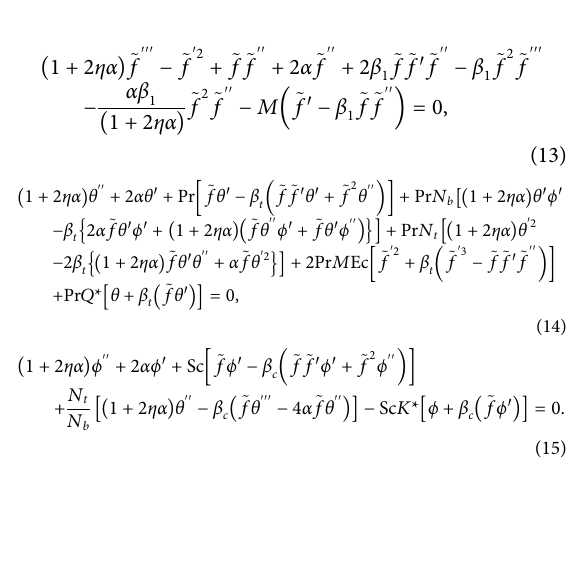
The dimensionless parameters involve the fl uid relaxation time parameter β 1 , the curvature parameter α , the magnetic fi eld parameter M , the Prandtl number Pr, the Schmidt number Sc, the Brownian diffusion parameter N b , the thermophoresis parameter N t , the thermal relaxation time parameter β t , the solutal relaxation time parameter β c , the Eckert number Ec due to the stretching of the cylinder in the z -direction, the heat generation parameter Q *, and the chemical reaction parameter K *, respectively.